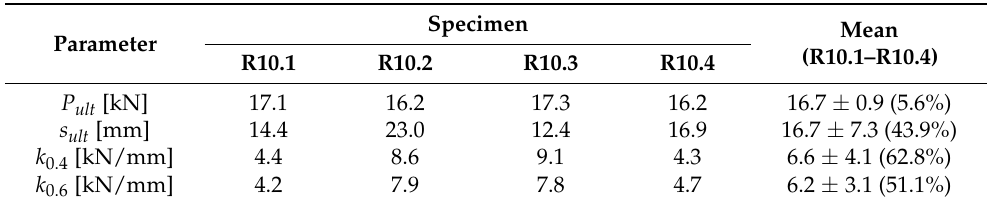
Table 8. The results of the push-out tests of the shear connections with 10 mm screws and without toothed-plate connectors (per one connector).